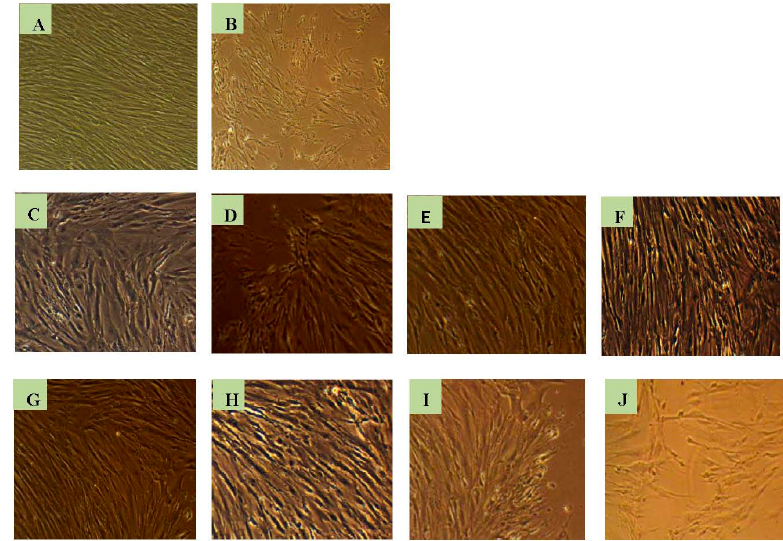
Figure 8. Morphological changes of WI-38 cells under an inverted phase contrast microscope (10×). represent the cells pre-incubated with test compounds for 48 h followed by H 2 O 2 -induced oxidative injury: ( C ) Stearic acid derivative of Q3G; ( D ) Oleic acid derivative of Q3G; ( E ) Linoleic acid derivative of Q3G; ( F ) ALA derivative of Q3G; ( G ) EPA derivative of Q3G; ( H ) DHA derivative of Q3G; ( I ) Q3G and ( J )